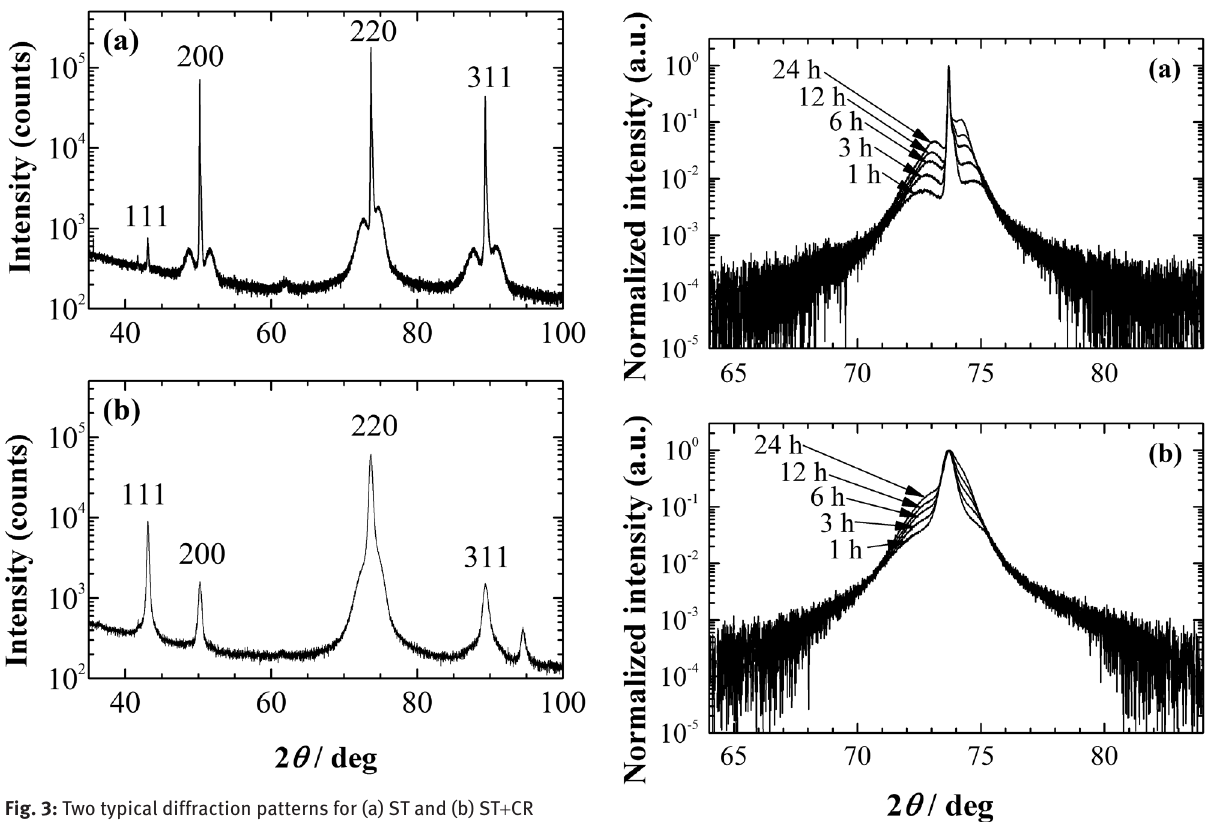
Fig. 3: Two typical diffraction patterns for (a) ST and (b) ST + CR specimens aged for 1 h.